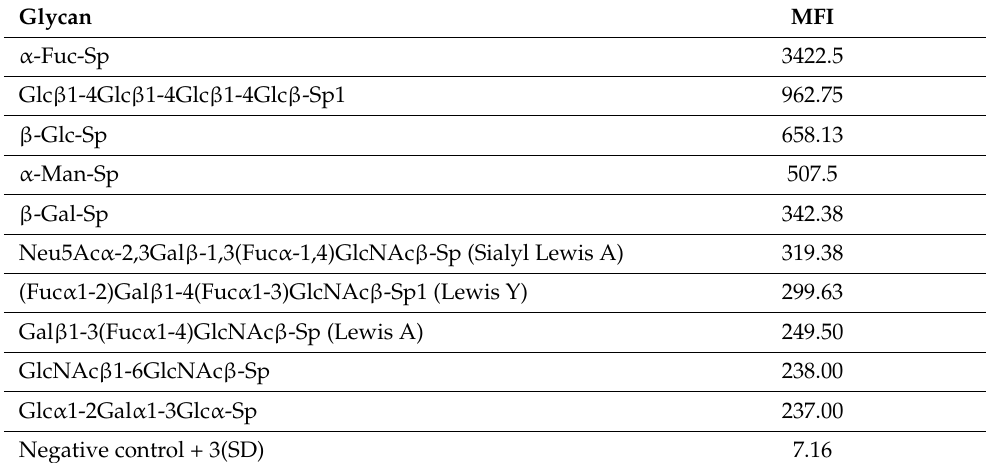
MFI, Median Fluorescence Intensity after background subtraction (range − 1.63 to 3348.25). Glycans were sorted based on MFI with the top 10 glycan binders